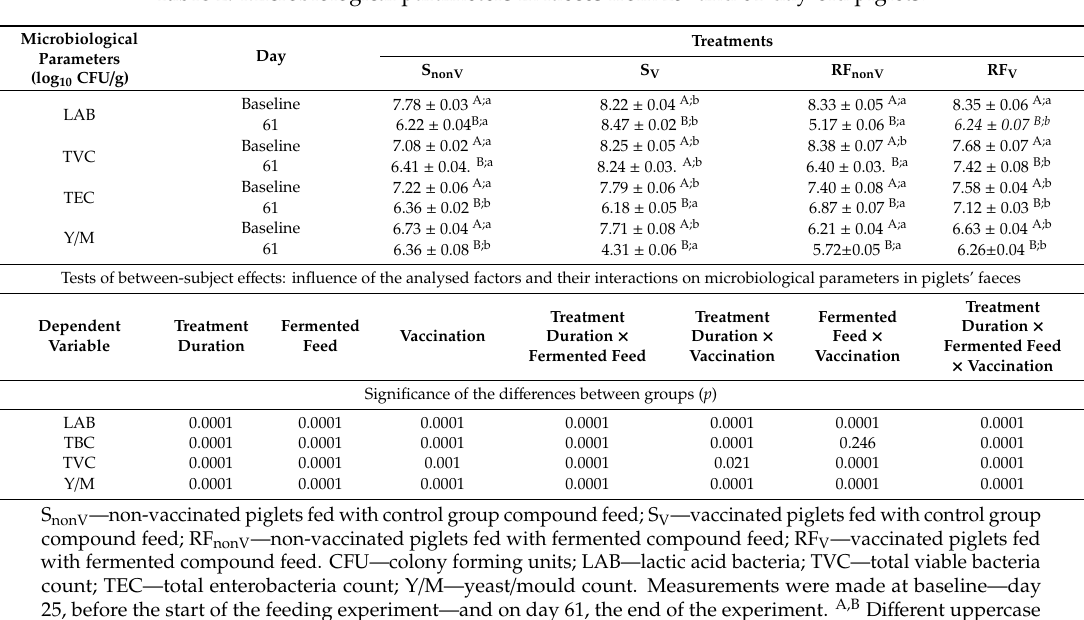
Table 2. Microbiological parameters in faeces from 25- and 61-day-old